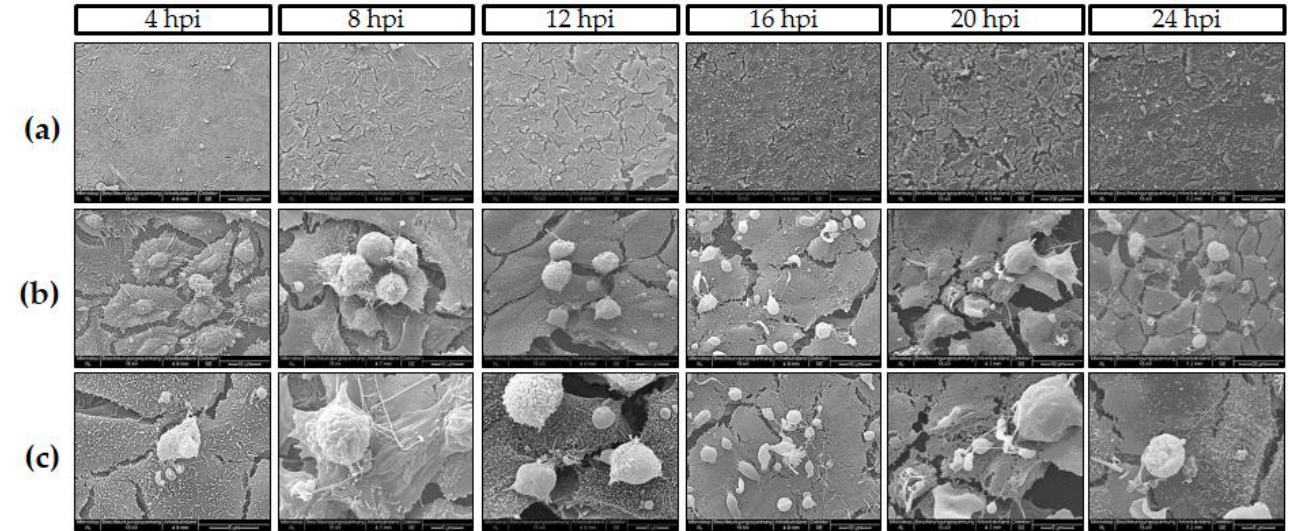
Figure 2. C. parvum development in HCT-8 cells under hyperoxic (21% O 2 ) conditions ( n = 6). SEM-based illustration of C. parvum -infected HCT-8 evidenced rapid C. parvum development and infection kinetics: ( a ) Overviews at different time points post infection (4–24 h p. i.). ( b , c ) Closer views of parasite stages-host cell interactions, i.e., column at 16 h p. i. shows meront-infected cells, row b evidenced hole-like damage on host cell surface induced by merozoites release at the same time point (white arrow). Row c (4 h p. i.) reveals early induction of villi-like structures on surface of infected cells (black arrows).